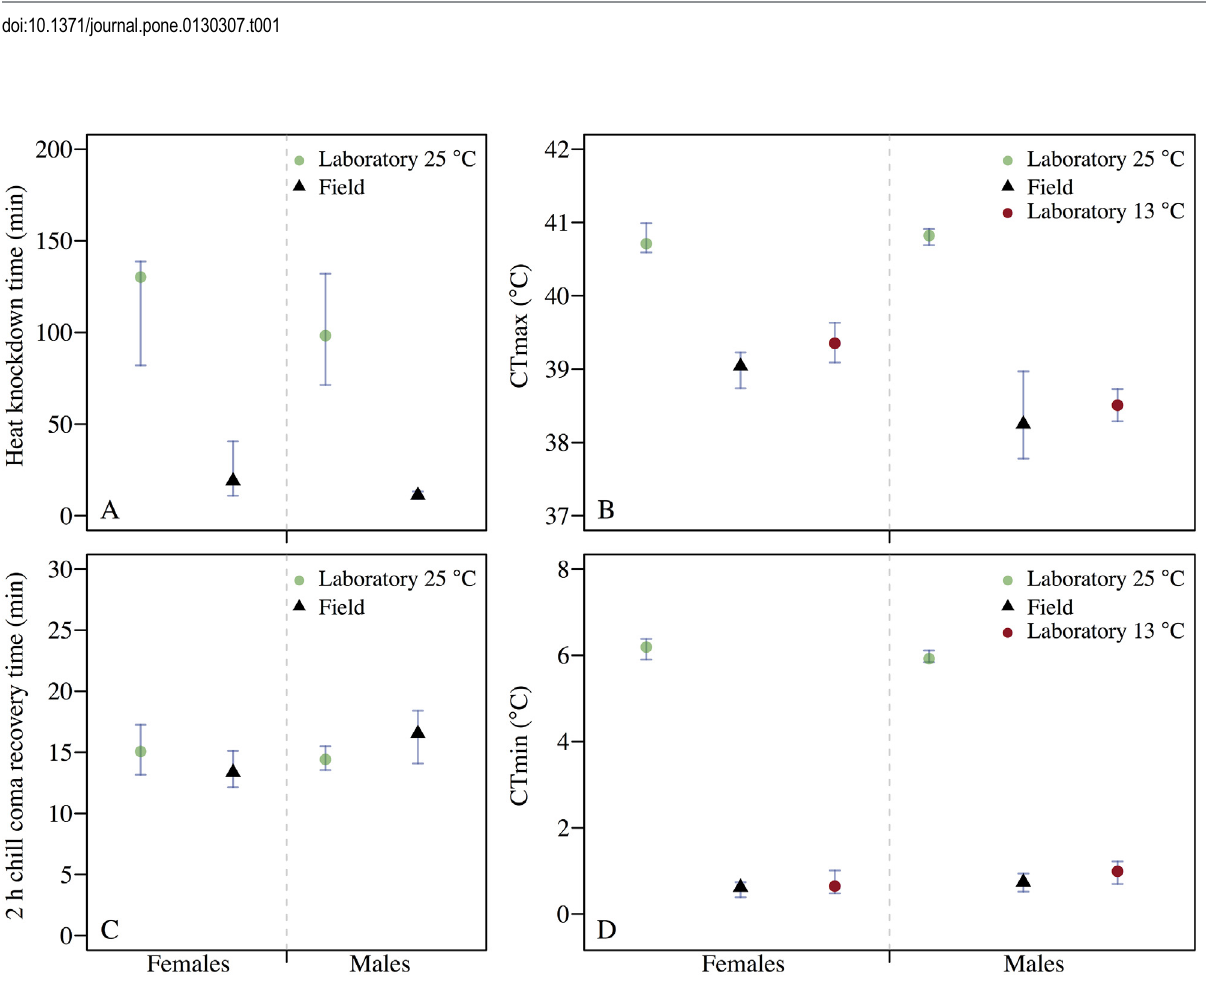
Fig 2. Thermal tolerance assays. Medians with 95% confidence intervals (obtained with bootstrapping; n = 10,000) for stress tolerance of male and female flies from the laboratory reared at 25°C and the field in four temperature stress assays: (A) heat knockdown; (B) heat ramping; (C) 2 h chill coma recovery; (D) cold ramping, n = 22 – 25. Heat and cold ramping were also performed on laboratory flies reared at